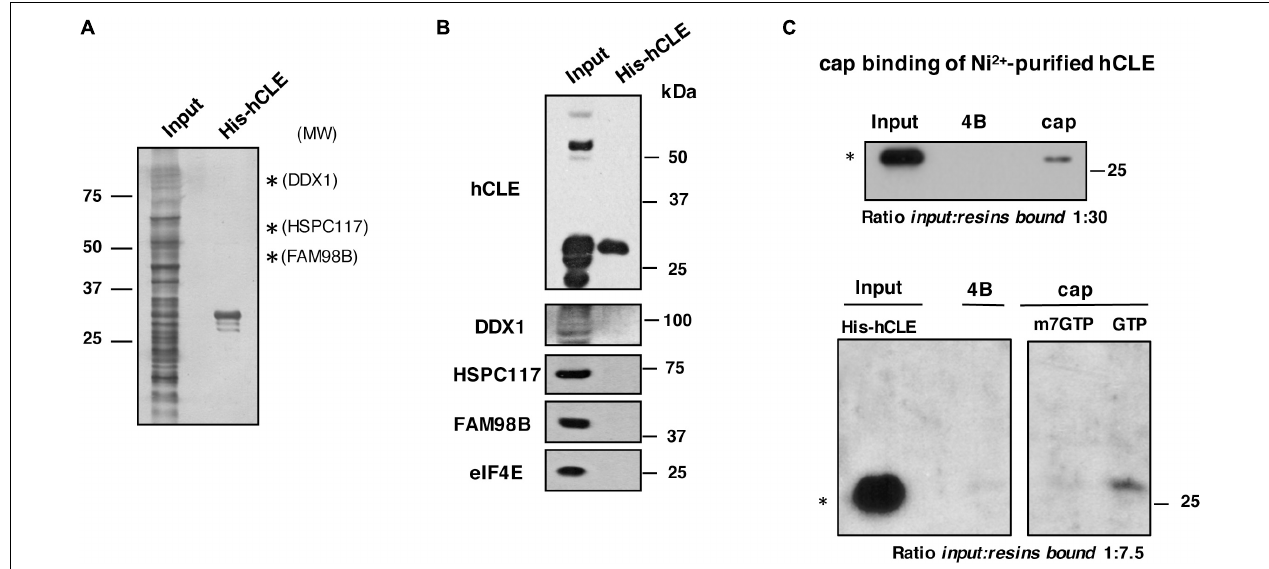
FIGURE 4 | Purified hCLE binds cap analog. (A) Silver staining of Ni 2 + -purified His-hCLE protein. Only hCLE is visible after purification; arrows indicate molecular weight for associated proteins. (B) Western blot analysis of indicated proteins in total extracts (Input) or purified fraction of His-hCLE. To obtain the most accurate results, we analyzed all the proteins from the same sample and experiment. (C) (Top); Binding of Ni 2 + -purified His-hCLE proteins to cap analog and control resins. Bound protein was analyzed by Western blot. The relative amounts applied to SDS-gels were Input:resins bound 1:30. (Bottom); Purified His-hCLE was incubated with cap analog (cap) or control resins (4B) in the presence of 10 mM of GTP, or m 7 GTP as competitors and His-hCLE binding was analyzed by Western blot. The relative amounts applied to SDS-gels were Input:resins bound 1:7.5. The experiments were repeated at least three times. ∗ monomer.